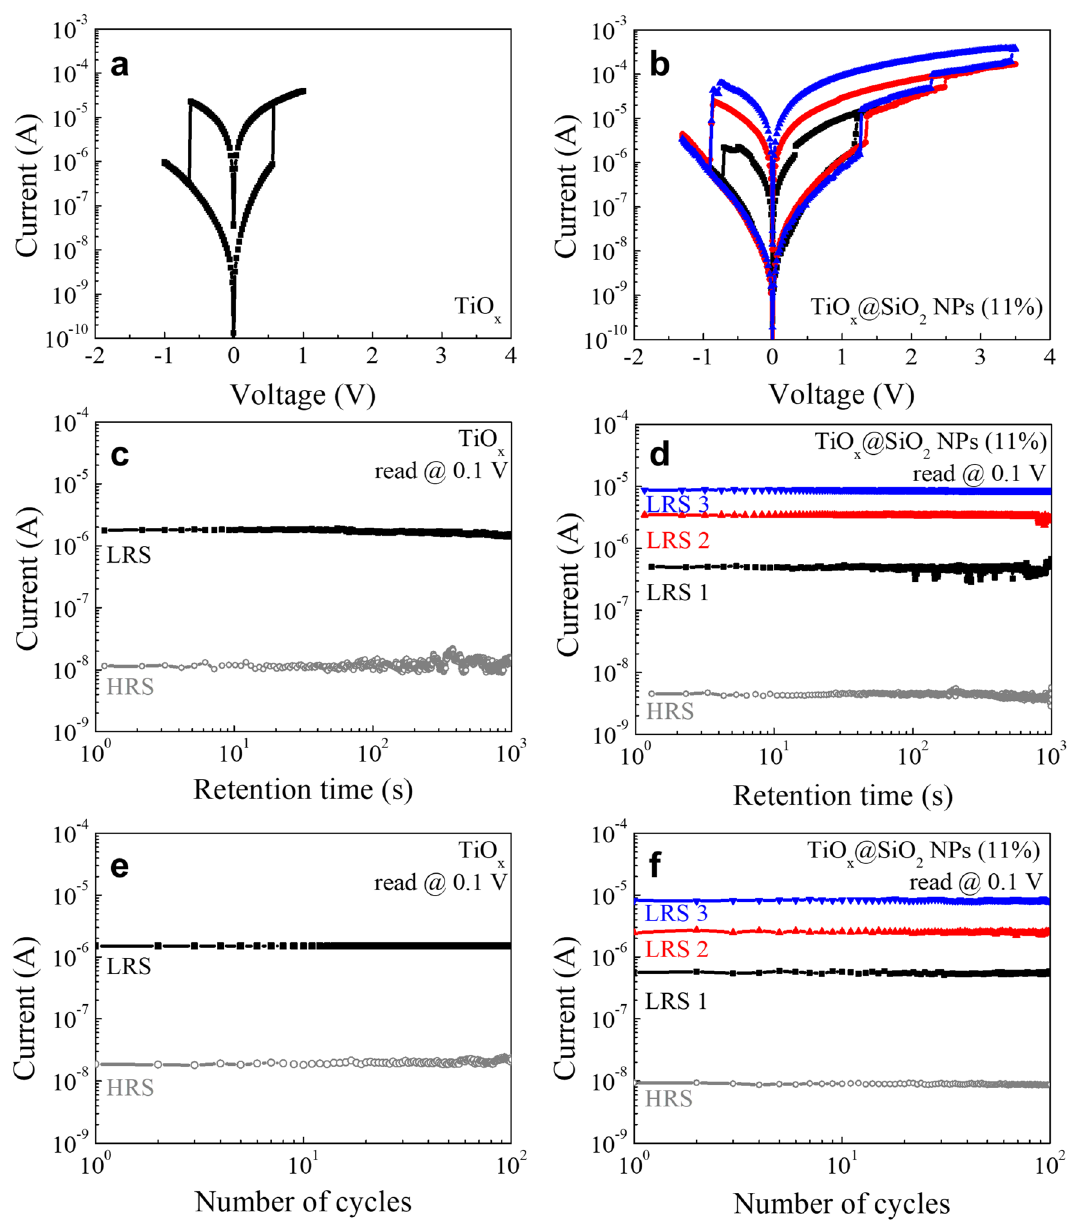
Figure 5. ( a,b ) Resistive switching curves, ( c,d ) retention performance, and ( e,f ) endurance performance of the